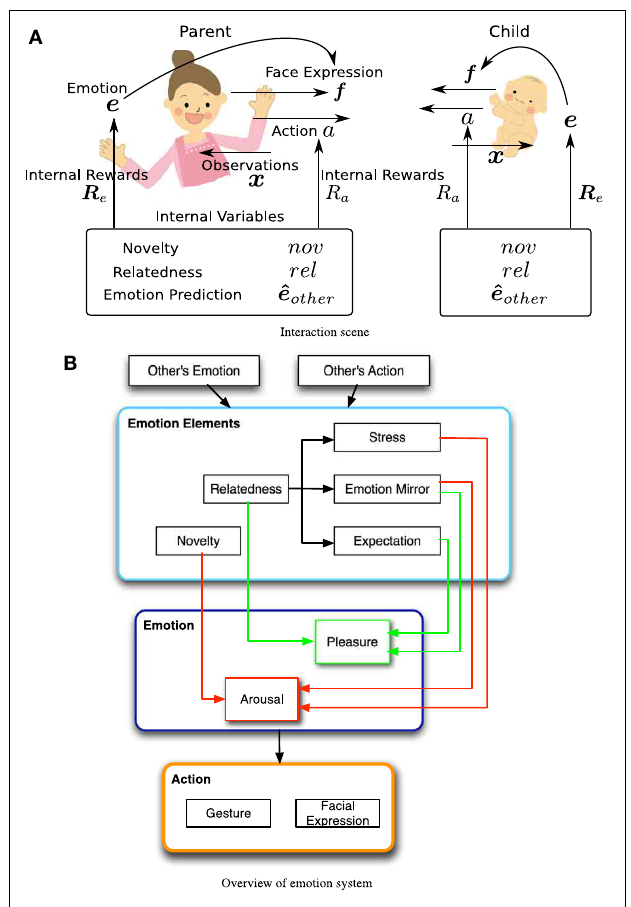
FIGURE 1 | (A) Variables used in the proposed model in an interaction situation. (B) Overview of the emotion